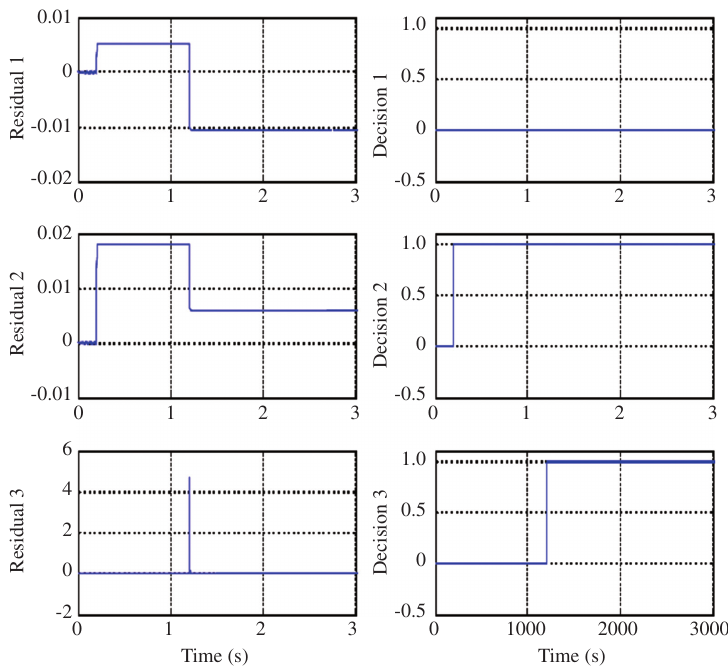
Figure 7. Residuals with a Non-additive Fault on Joint 2 at t = 0.2 s and Joint 3 at t = 1.2